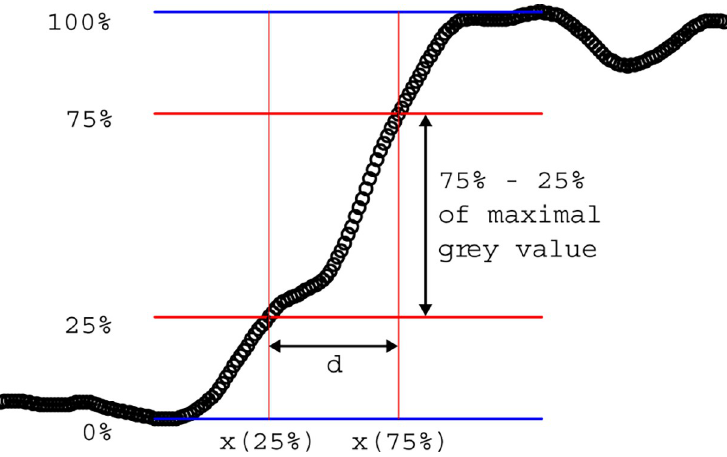
Fig 3. Contour sharpness parameters. Illustration of the measurement of the two different contour sharpness parameters. We used two different parameters to objectively evaluate the contour sharpness: the distance between 25% and 75% of the maximal grey value and the slope defined as the difference between 75% and 25% of the maximal grey value in the contour divided by the distance calculated before. d (Distance) = x(75% of the maximal grey value)–(25% of the maximal grey value) m (Slope) = (75% of maximal grey value– 25% maximal grey value)/d.